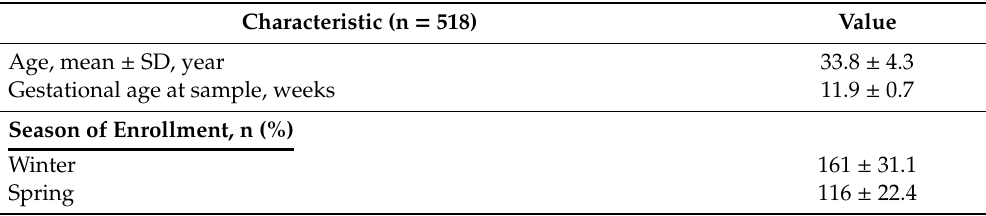
Table 1. Characteristics of study